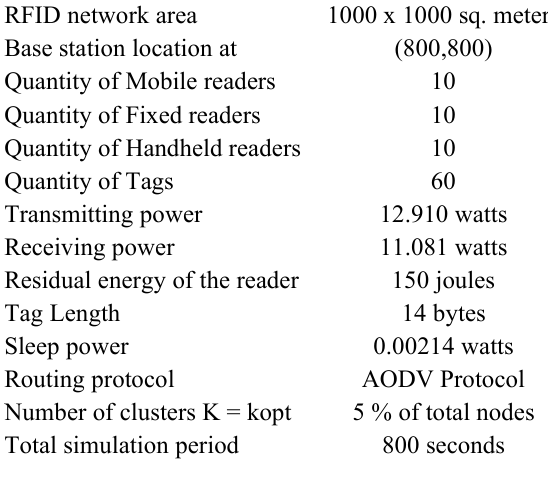
Figure 9. Collision Rate vs. Number of Clusters